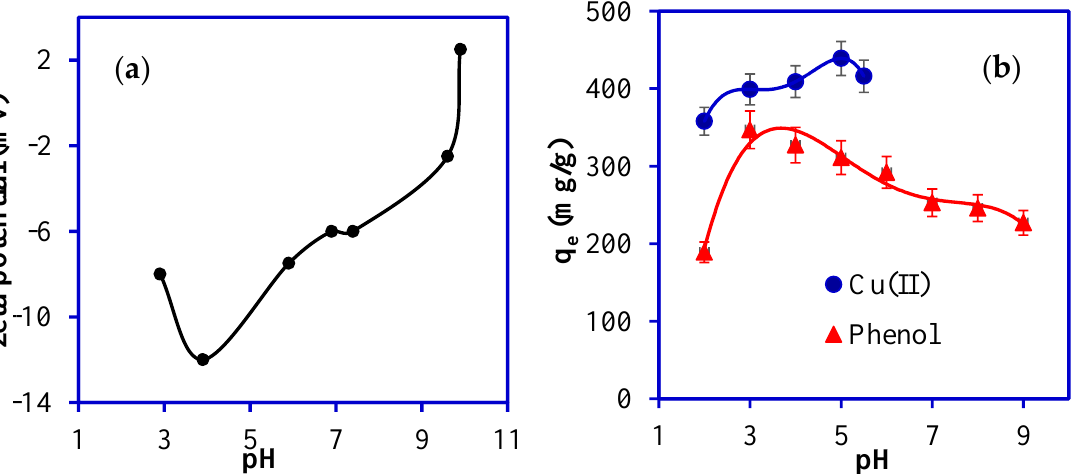
Figure 5. ( a ) Zeta potential analysis, ( b ) the effect of solution pH on adsorption of Cu(II) and phenol (concentration, 500 mg/L; adsorbent dosage, 0.02 g; volume, 20 mL; temp, 30 °C).